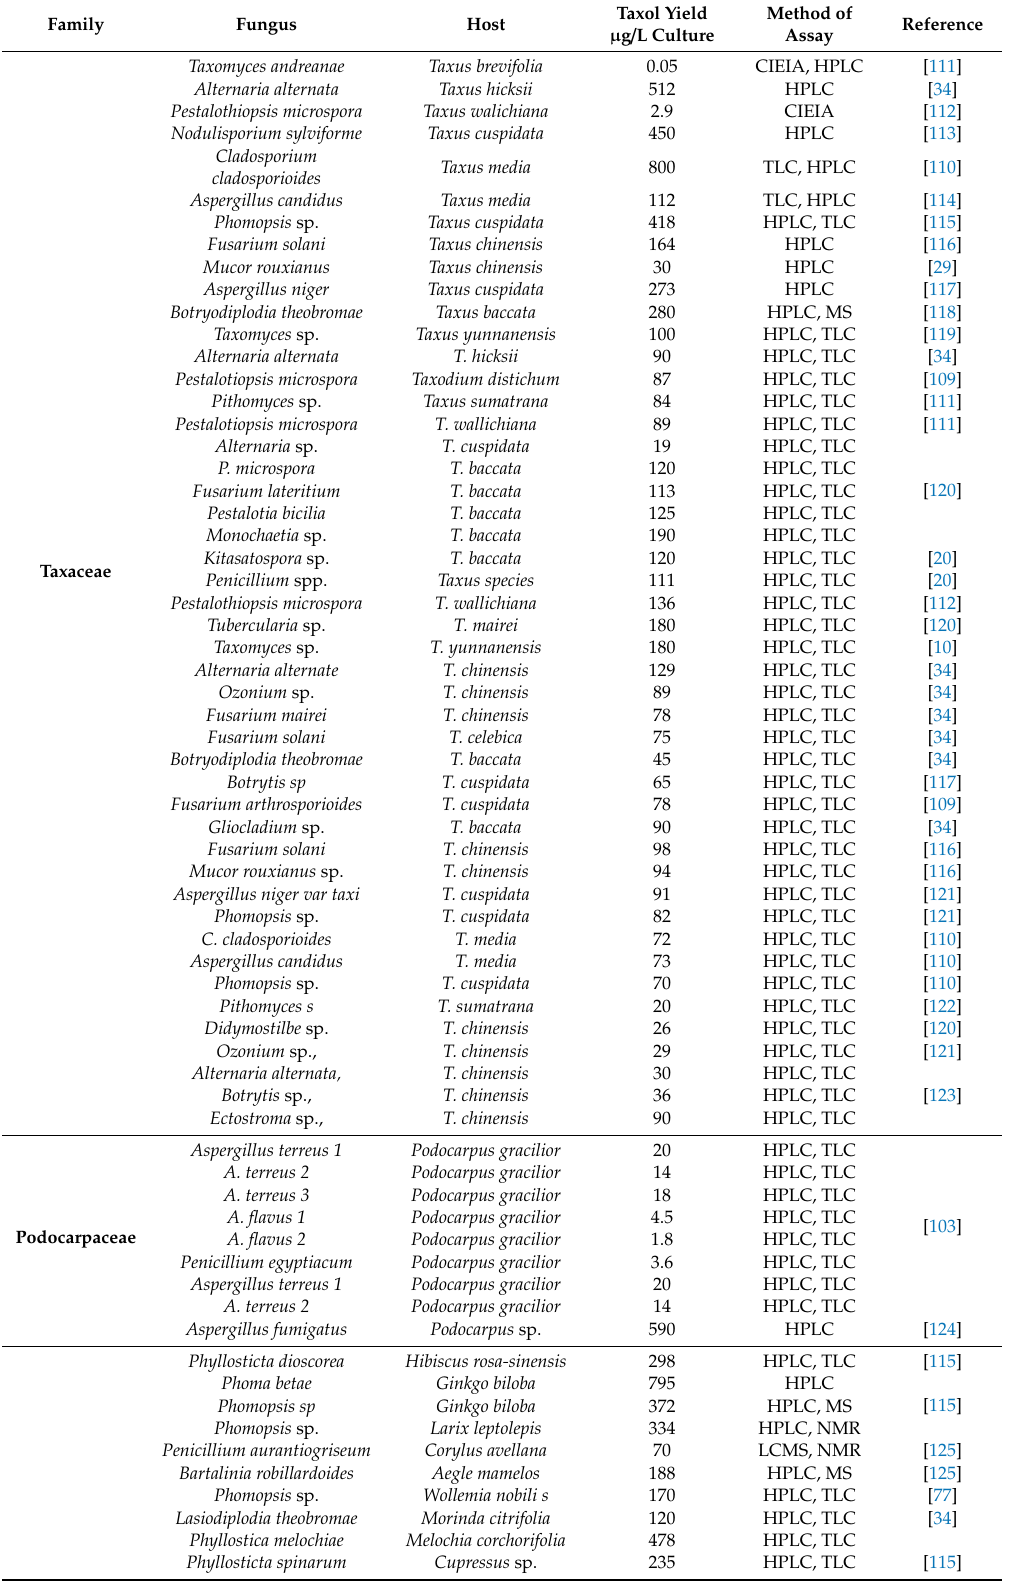
Table 1. Taxol producing fungi and their